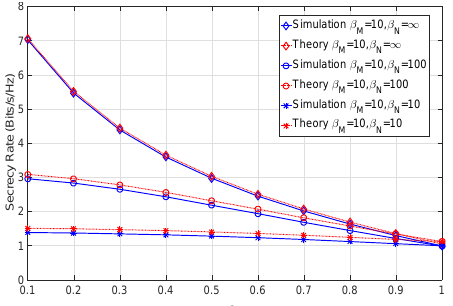
Figure 7. Secrecy rate of the system for an SNR of 12 dB and β M = 10 with various levels of channel estimation error.